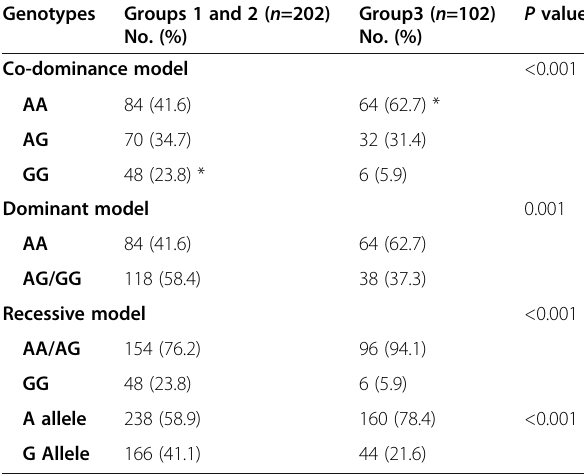
Table 4 ELMO1 rs741301 allele and genotypes distribution in patients and controls